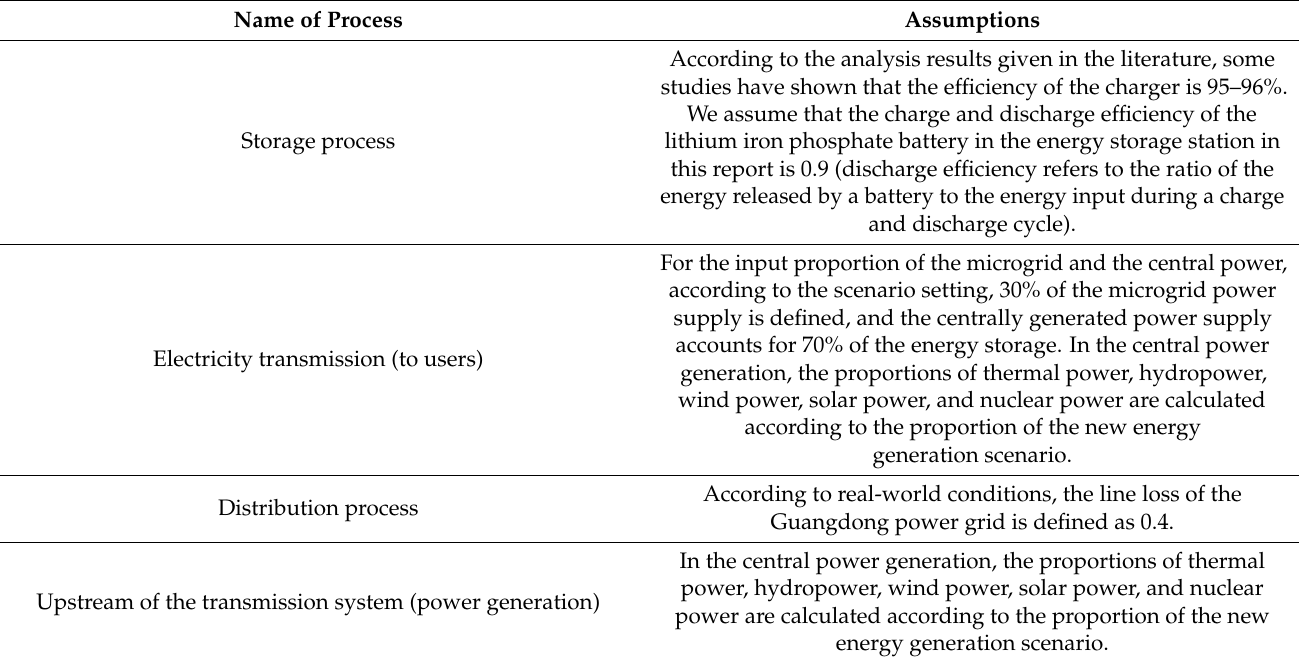
Table 2. Assumptions of the LCA